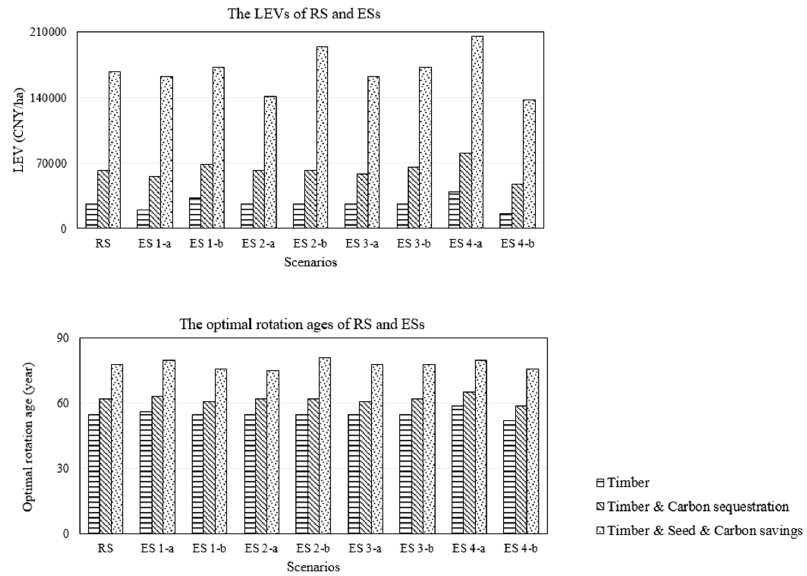
Figure 3. Comparisons of LEVs and optimal rotation ages of different (joint) values—RS and ESs.